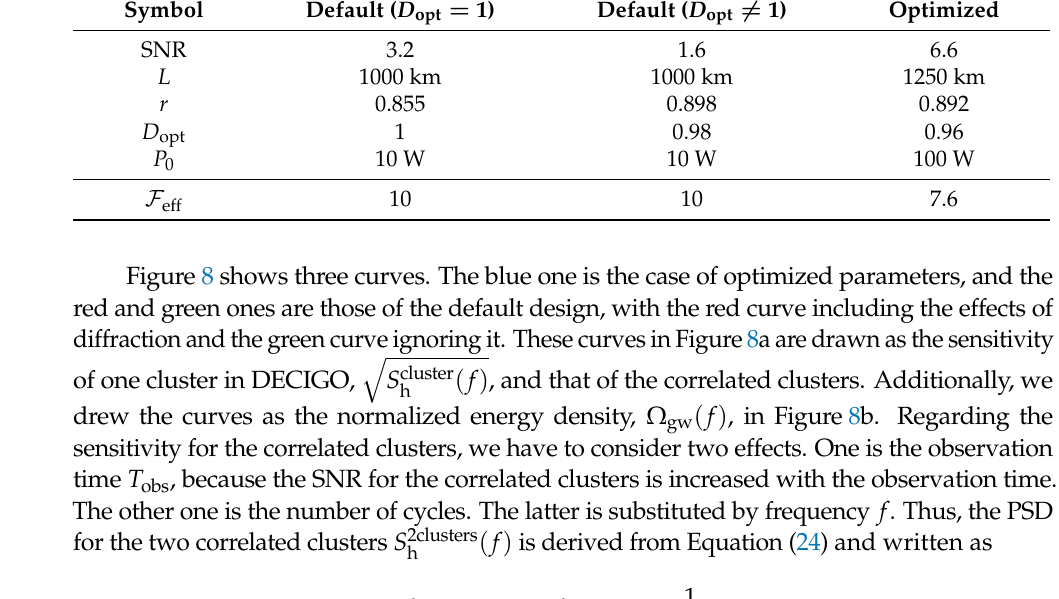
Table 2. Optimized SNR and parameters from Figure 7, R = 0.5 m. The last line shows the effective finesse calculated from r and D opt2 in Equation (30). For comparison, the parameters in default DECIGO are also listed. In default DECIGO, we show two cases: ignoring the diffraction loss and considering it. The values of r and D opt in the two default DECIGO cases are decided by two conditions: F eff = 10 and D opt condition. From Figure 8a, the cavity pole frequencies f p are a few Hz and not relevant in the frequency range where there is a chance to detect the primordial GWs.